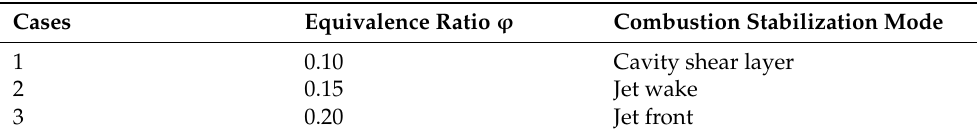
Table 1. Equivalence ratios for various flame stabilization